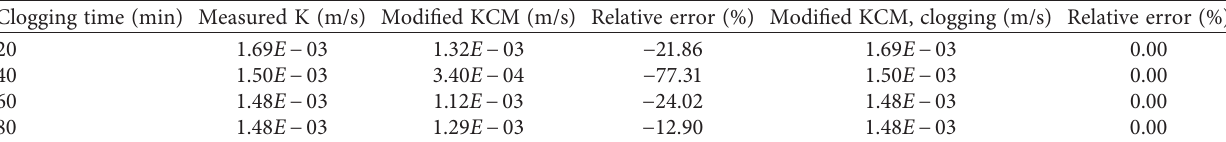
Table 3: Comparison results of permeability for PUPM